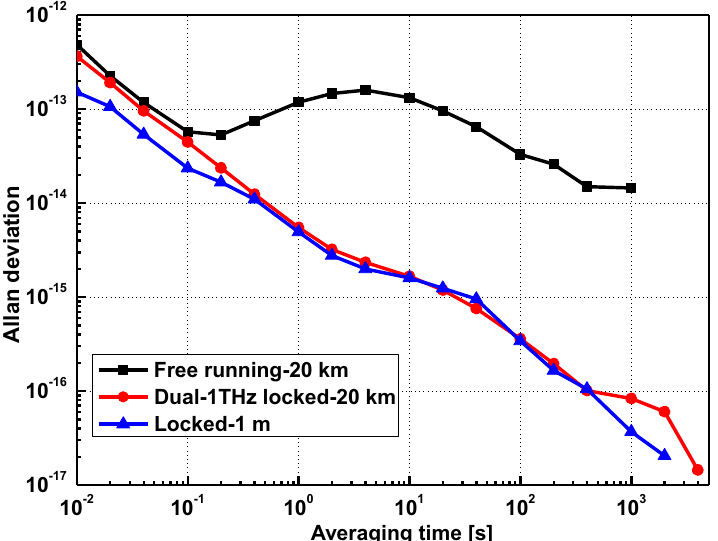
Fig. 5 The relative frequency stability of the two terahertz signal distribution systems in conditions of free-running spool fiber link, phase-locked spool fiber link, and phase-locked 1 m short fiber,